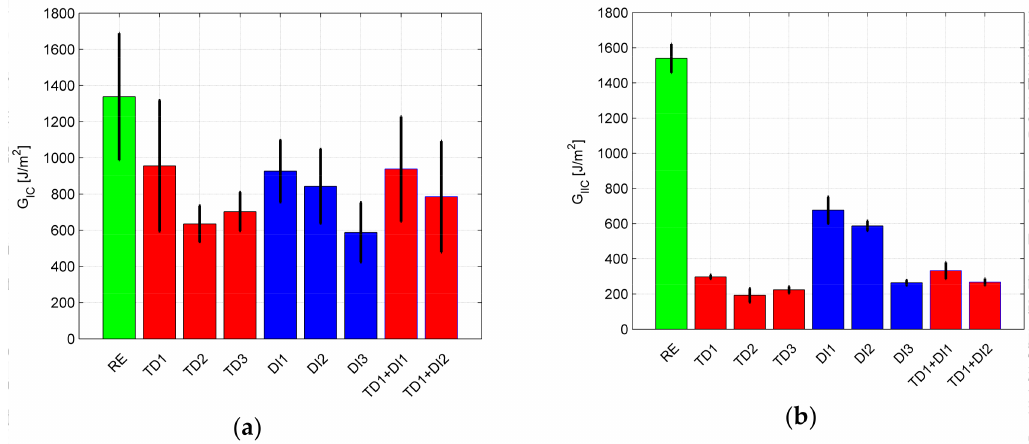
Figure 2. Results of the mechanical testing: ( a ) mode-I fracture toughness energy; ( b ) mode-II fracture toughness